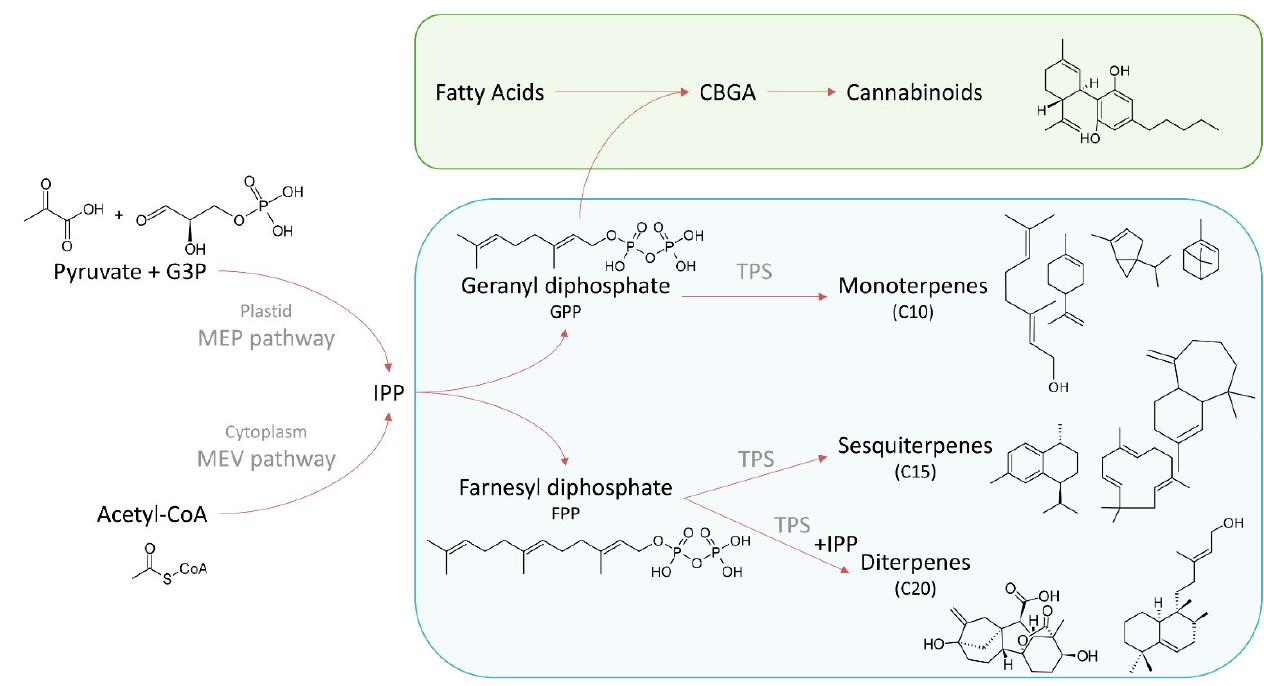
Figure 1. General scheme of terpene synthesis pathway in Cannabis sativa L.